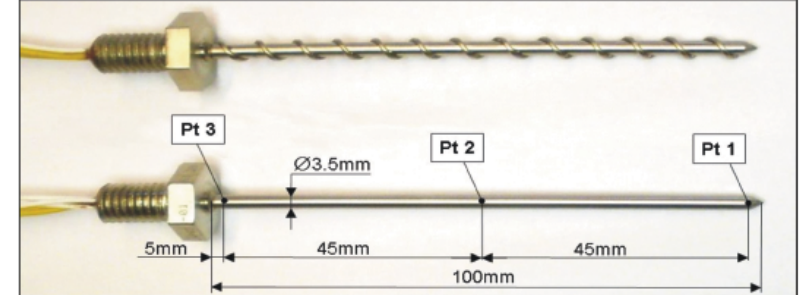
Fig. 4. The LNP02 (needle with winding) and LNP03 (plane needle)